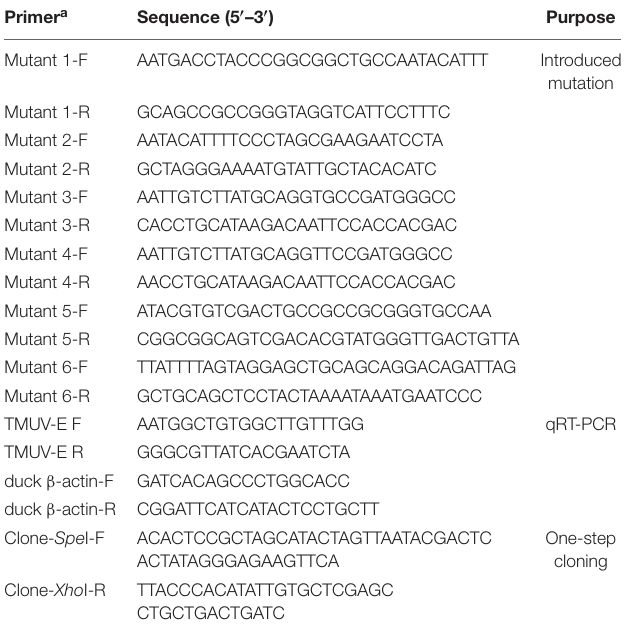
TABLE 1 | PCR primers used in this research. Sequence (5 (cid:48) –3 (cid:48)